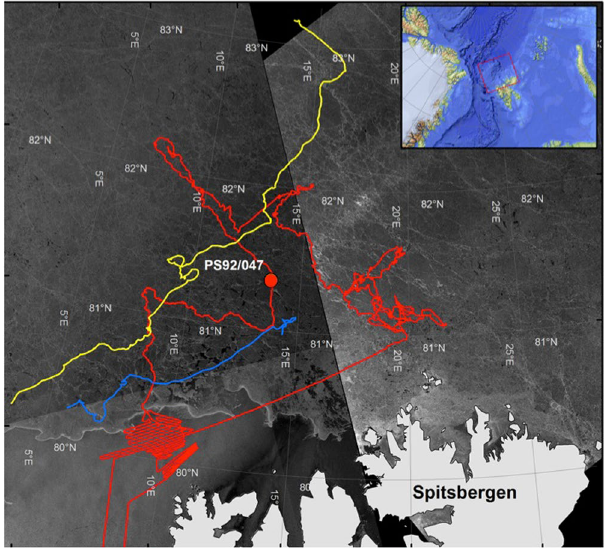
Figure 1. Map of the TRANSSIZ cruise track (red line) and drift trajectories of floes 3 (yellow) and 4 (blue) north of Spitsbergen from the N-ICE2015 campain. The red dot indicates the position of ice station PS92/47 in the Sophia Deep. The background image is a mosaic of radar images from 8 June 2015 (Sentinel-1 Radar Backscatter © ESA; Data Provider: Drift & Noise Polar Services). The map of the study area was created using ArcMap 10.4.1 (Esri) with the standard coastline dataset and bathymetry data from the General Bathymetric Chart of the Oceans (GEBCO)-08 grid, version 20100927, http://www.gebco.net, with permission from the British Oceanographic Data Centre